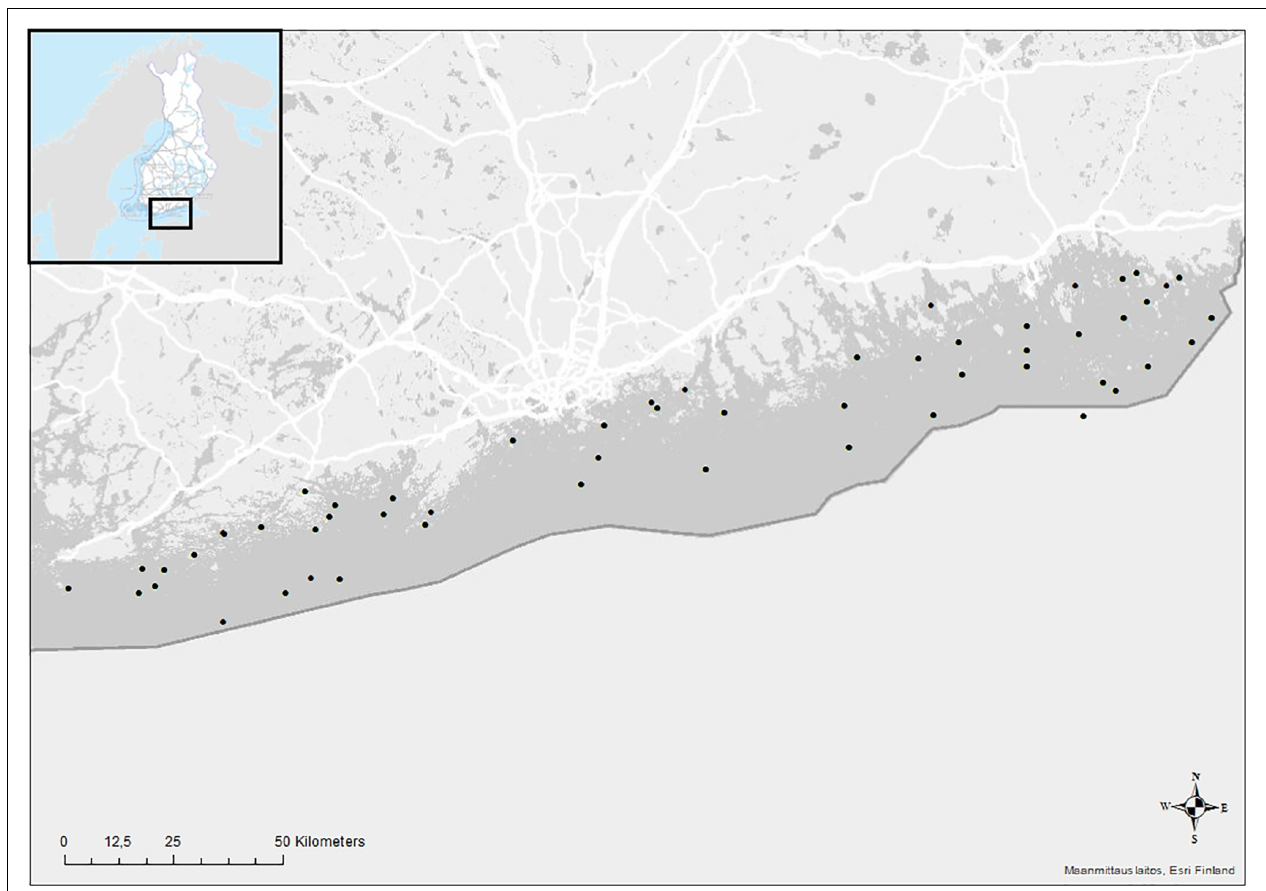
FIGURE 1 | Map of the study area and the sampling stations in the Finnish coast of the Gulf of Finland, the Baltic